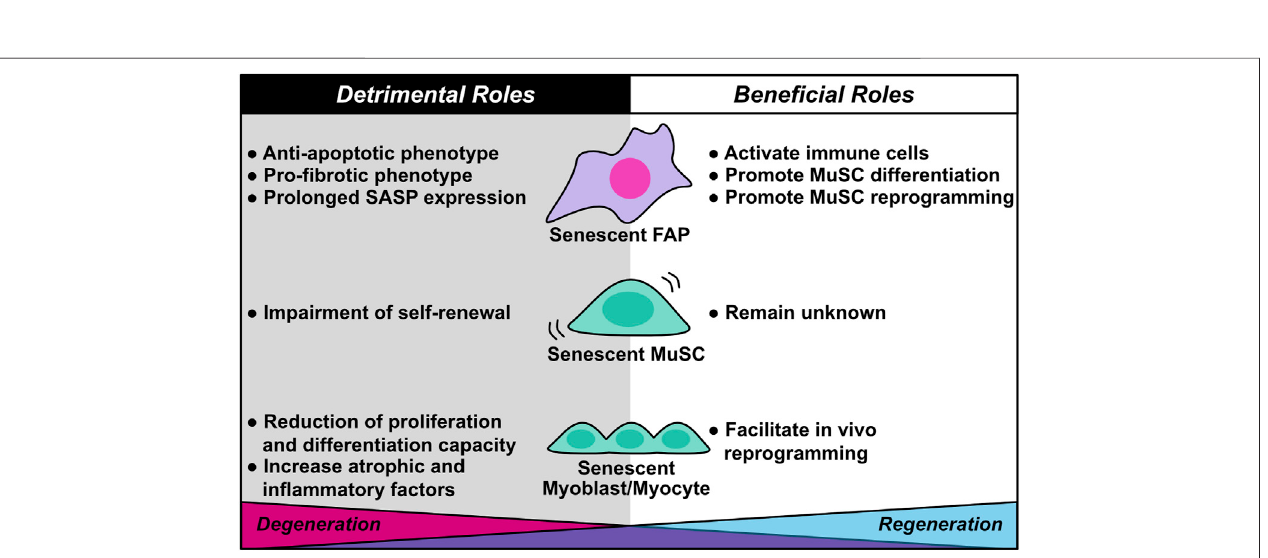
FIGURE4| Diverserolesofcellularsenescenceinskeletalmuscleregenerationanddegeneration.Cellularsenescenceinskeletalmuscleplaysdualrolesinmuscle regenerationanddegeneration.Althoughsenescent fi bro/adipogenicprogenitors(FAPs)activateimmunecellsandpromotemusclestemcell(MuSC)differentiationand reprogramming during muscle regeneration, they also contribute to muscle degeneration through anti-apoptotic and pro- fi brotic phenotypes, as well as prolonged SASP expression. Senescent MuSC exhibits impairment of self-renewal capacity, which induces stem cell exhaustion. The bene fi cial roles of senescent MuSC remain unknown. Senescent myoblasts/myocytes facilitate their own in vivo reprogramming, a bene fi cial role; however, senescent myoblasts/myocytes also contribute to muscle degeneration by decreasing proliferation and differentiation capacity and increasing expression of atrophic and in fl ammatory factors.